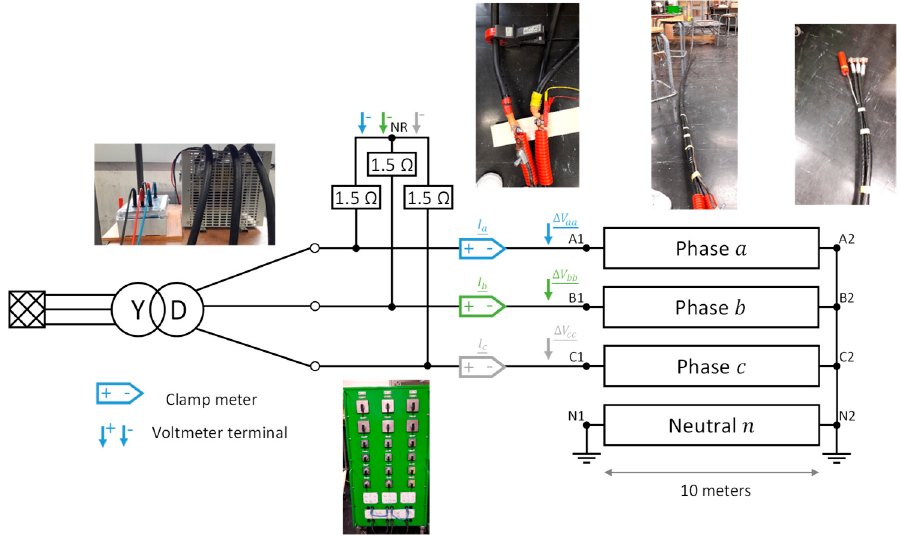
Figure 6. The experimental set-up for measuring cable